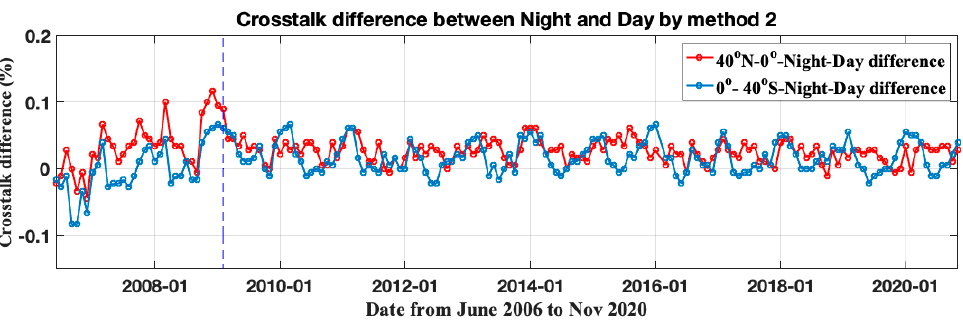
Figure 2. Time series of crosstalk difference between night and day ( CT p 2 s , night − CT p 2 s , day ) calculated from CALIOP L1 ocean signals by method 2 from June 2006 to November 2020 over two chosen regions 0 ◦ –40 ◦ N (red) and 0 ◦ –40 ◦ S (dark blue). The dashed blue line indicates when CALIOP was switched from the primary laser to the backup laser (i.e., February 2009).